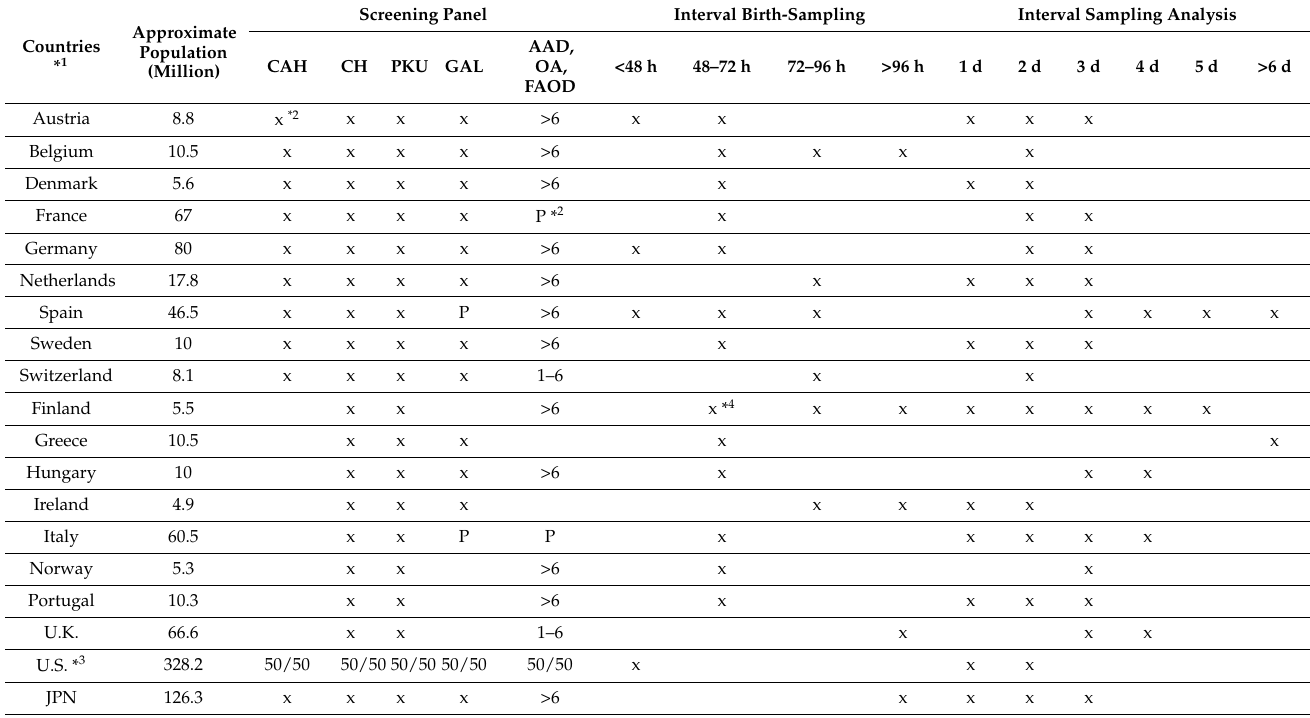
Table 3. Summary of newborn screening in European countries, Oceania, and the U.S. (modified table from ref- erence [25]) and the following website (https://www.hrsa.gov/advisory-committees/heritable-disorders/newborn- screening-timeliness.html, https://newbornscreening.hrsa.gov/your-state#w,